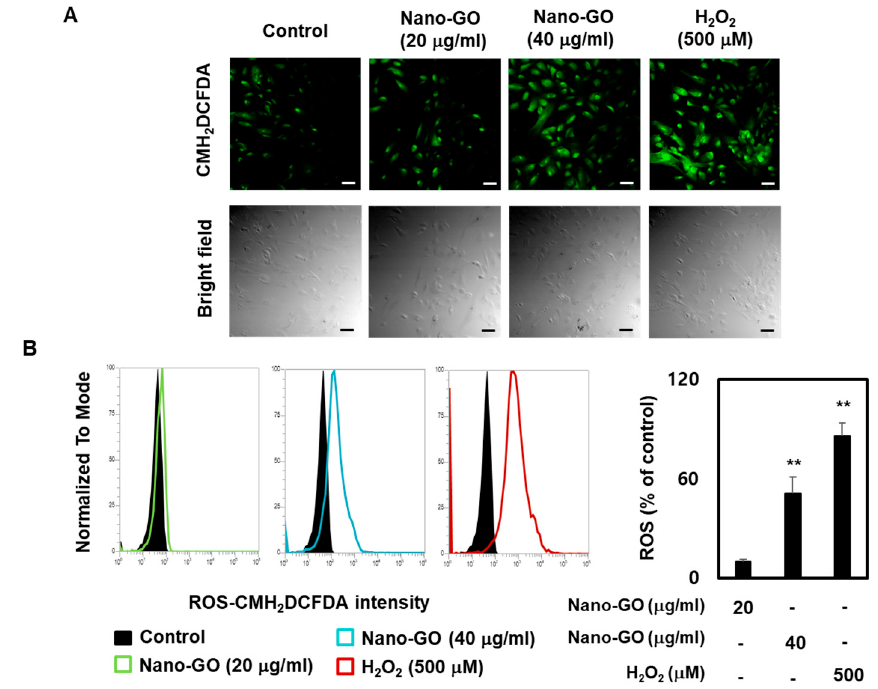
Figure 4. Effect of Nano-GO on intracellular ROS production in RPE cells. The RPE cells were treated with Nano-GO (20 and 40 µ g/mL) for 24 h. ( A ) Intracellular ROS production was visualized by Carl Zeiss fluorescence microscopy using CM-H 2 DCFDA staining (scale bar; 50 µ m). ( B ) Representative flow cytometer-based image (upper panel) and quantitative analysis (lower panel) indicates fluorescence intensity using CM-H 2 DCFDA staining. All data are presented as the mean ± SEM ( n = 3). * p < 0.05 and ** p < 0.01 compared to the Control.